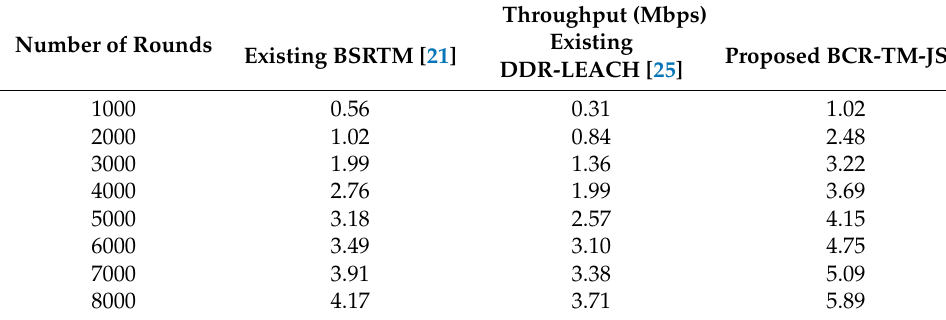
Table 4. Performances of FPR and FNR.